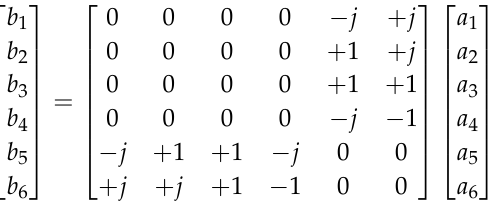
Figure 2. Block diagram of the six-port interferometer.